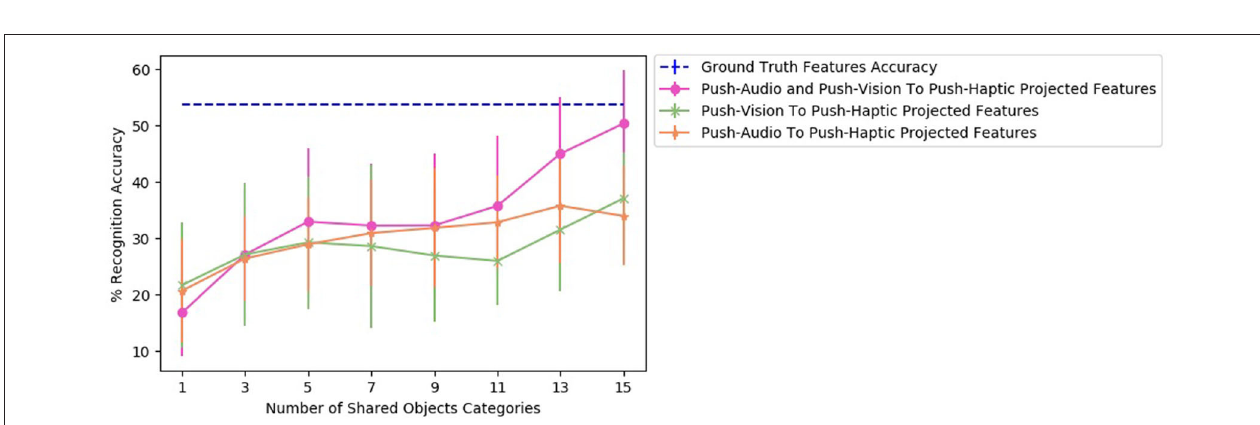
FIGURE 8 | Visualizations of: (A) the source robot’s features; (B) the target robot’s projected features using β -VED, and (C) the corresponding ground truth features captures by performing tap behavior on an object from the bottles category.